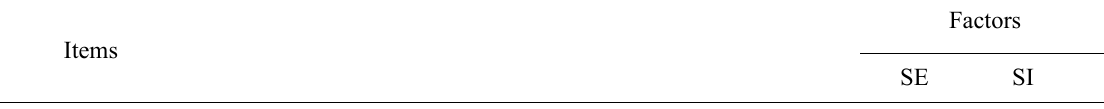
Items and Factor Loadings of the Exploratory Version of the WR-SRPS - Supervisors Items